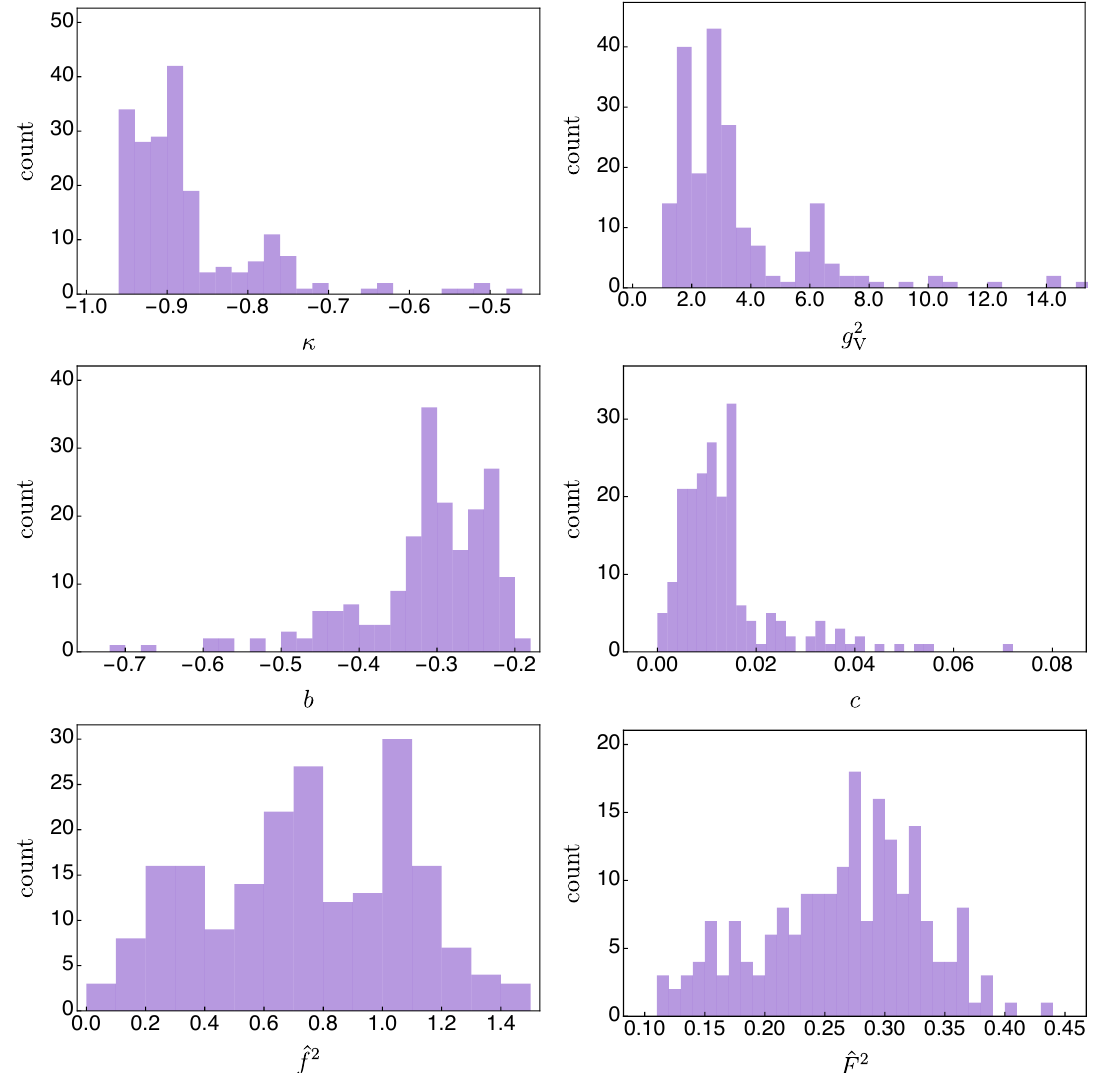
Figure 21. Histograms of the distribution of the six low-energy constants appearing in the EFT of section 6.1 at the leading order, as determined from the global (cid:12)t.